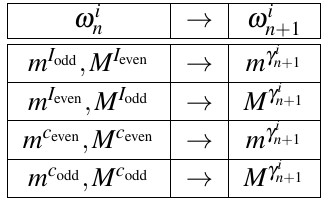
Table 1 Transition rules for l -modal maps with a positive shape.